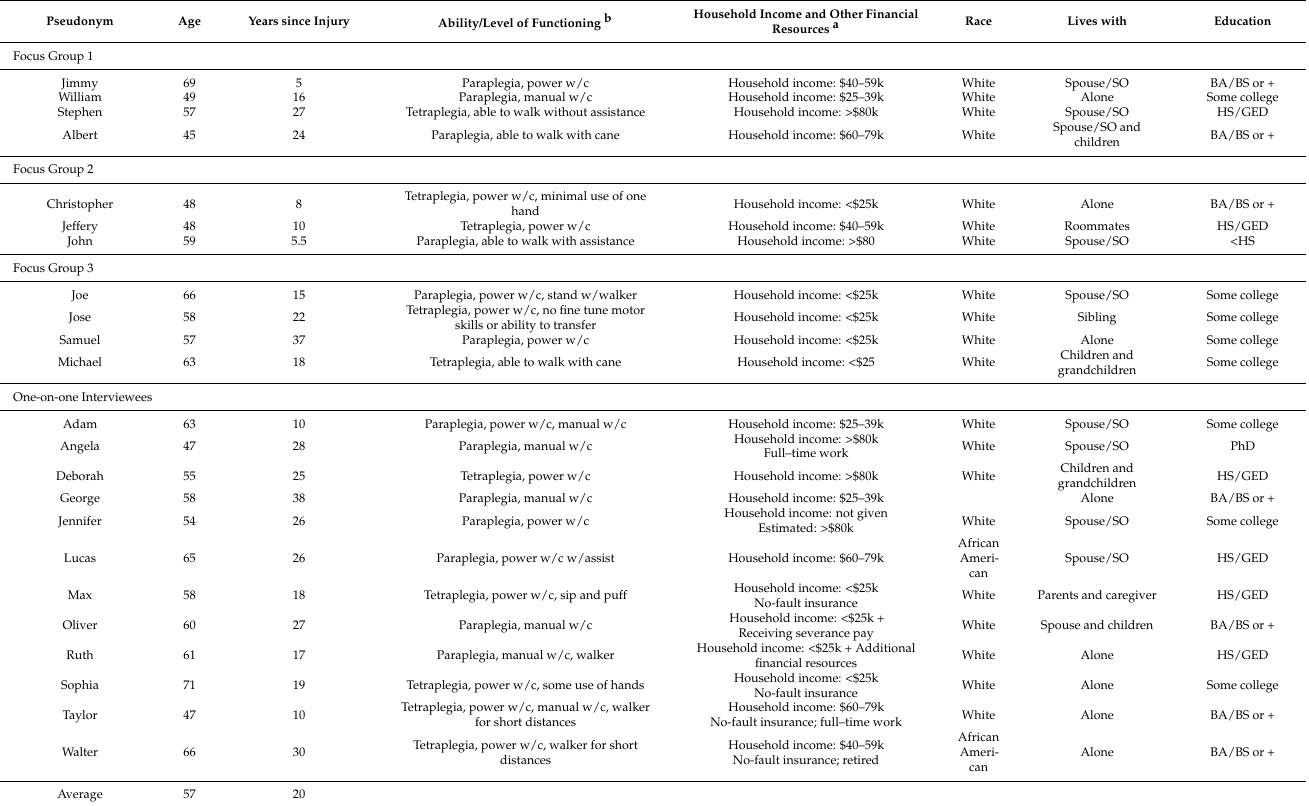
Table 1. Participant